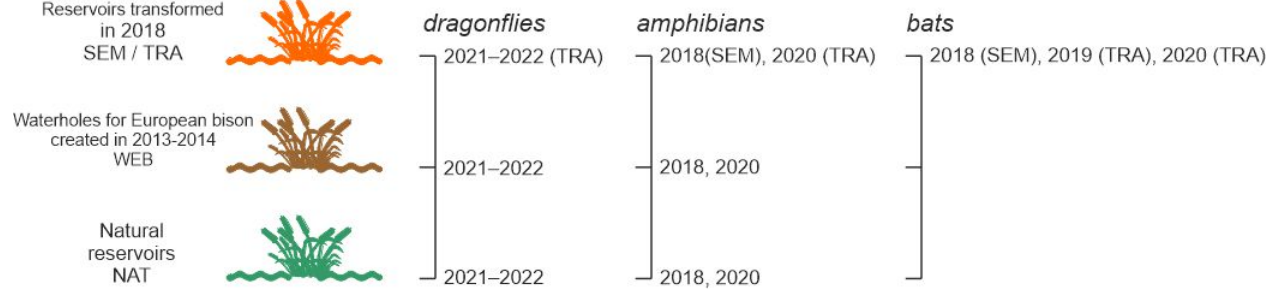
Figure 2. The scheme of the studied taxonomic groups in the given reservoirs ( SEM- seminatural reservoirs before transformation, TRA-reservoirs after